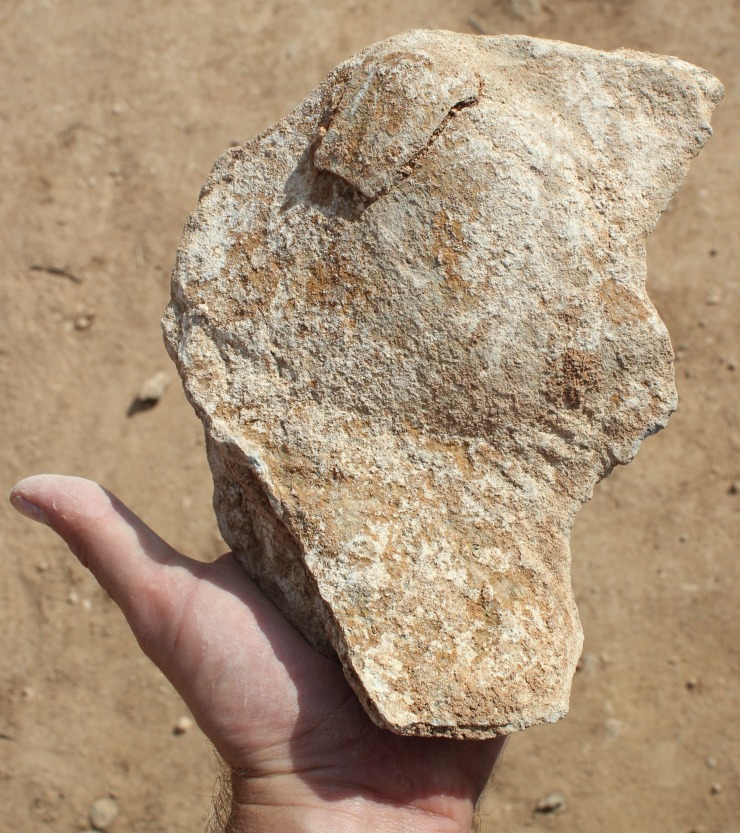
A giant flake from Layer E with the erraillure flake still adhering to it.